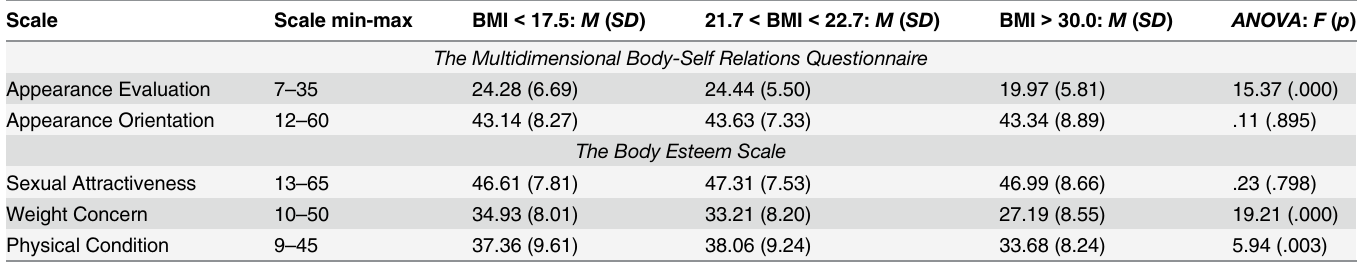
Table 1. Differences in the self-perception of attractiveness in women with different